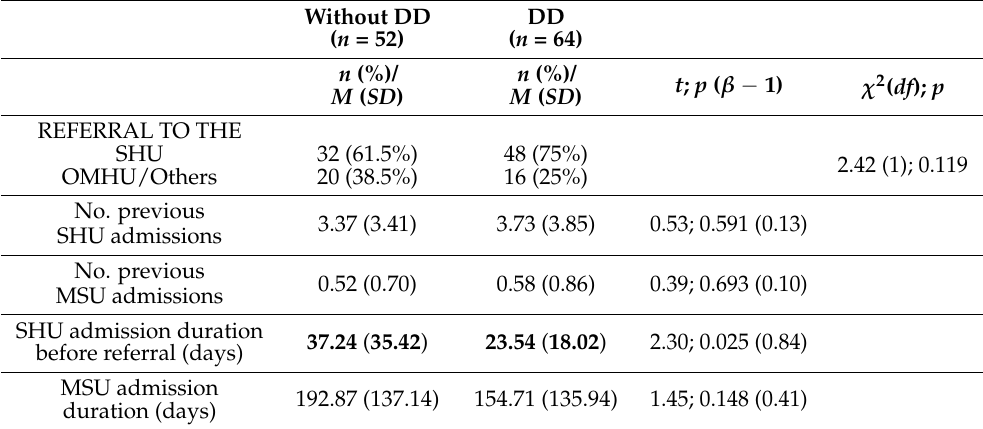
Table 2. Differences in the variables related to the admission of patients with or without dual disorder